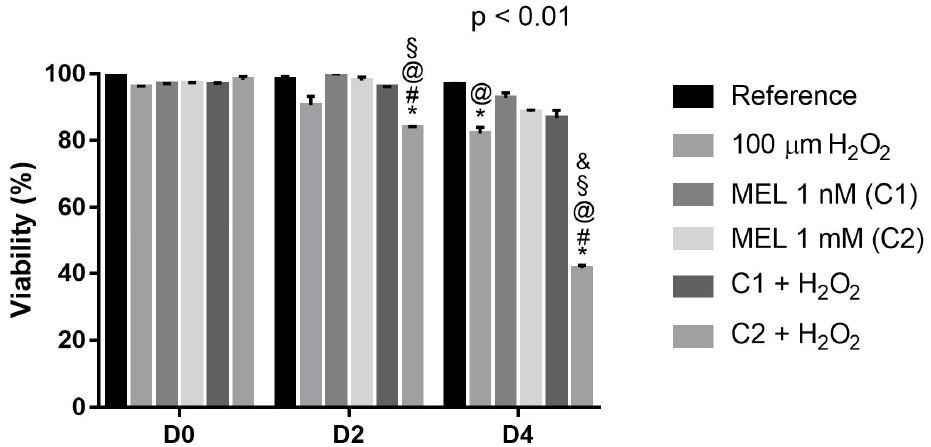
Figure 1. Viability of K562 cells followed for 5 days of culture with and without induction